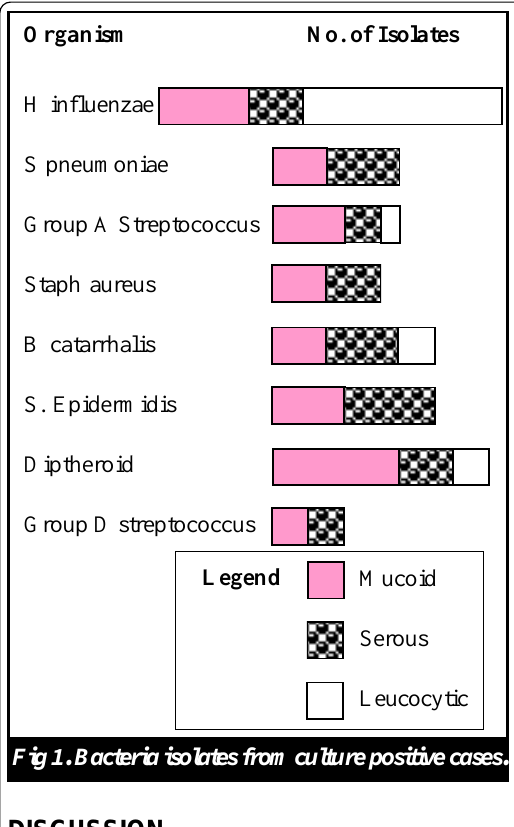
Fig 1. Bacteria isolates from culture positive